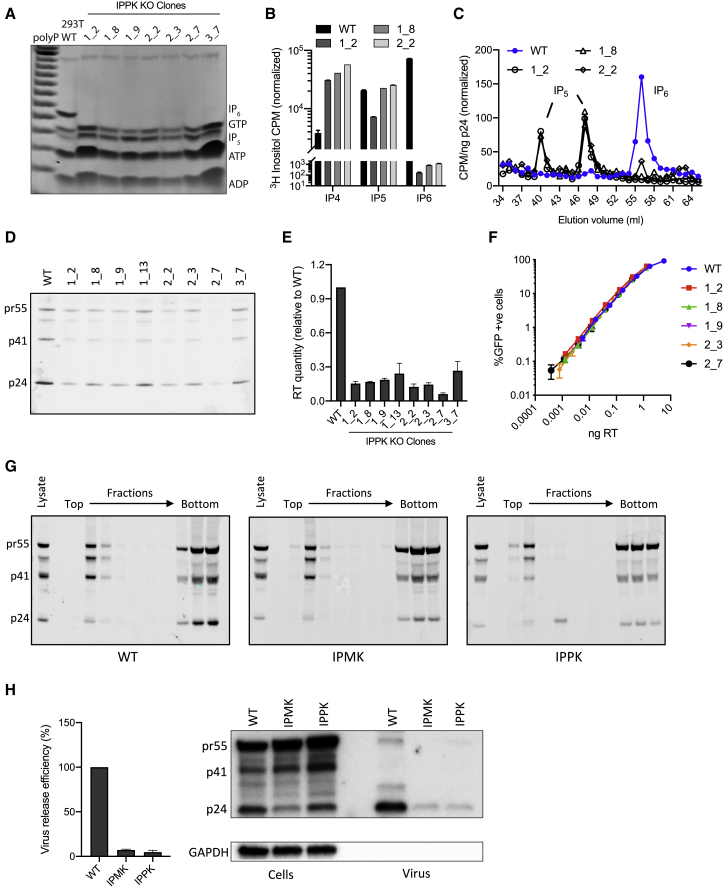
HIV Incorporates IP5 in the Absence of IP6 without Loss of Production or Infectivity(A) TiO2-PAGE and toluidine blue staining of cell extracts showing IP5 and IP6 levels in IPPK CRISPR/Cas9 knockout clones.(B) Inositol phosphate quantification in selected IPPK-KO clones using 3H-inositol labeling and inositol phosphate fractionation by SAX-HPLC.(C) Quantification of IP5 and IP6 packaging in virions produced in wild-type and IPPK-KO cells through [3H]inositol labeling, SAX-HPLC, and scintillation counting of fractions.(D) p24 western blot of pelleted virions showing p24 levels in HIV virions produced from IPPK-KO clones.(E) Measurement of virus production through quantification of RT in viral supernatants from IPMK-KO clones. Error bars depict mean ± SD of three independent experiments. Values are represented as fold WT virus, and reduction compared with WT is statistically significant (p < 0.0012 in all cases).(F) Infectivity of viruses from (E), as a function of viral dose measured by RT levels. Error bars depict mean ± SD of three replicates from one experiment representative of three independent experiments.(G) Membrane flotation analysis of cell lysates from WT, IPMK-KO, and IPPK-KO cells. Western blotting of sucrose gradient fractions for Gag show that similar levels of Gag are associated with the membrane fractions. Gag precursor Pr55Gag (pr55), p41, and mature capsid protein (p24) are indicated.(H) Virus release assays showing levels of Gag in lysates and virions after transduction of WT and KO cells with virus produced in WT cells. Graph shows relative quantification of p24 from two independent experiments and western blots. Representative data from at least two independent experiments are shown, unless otherwise indicated. CPM data are normalized to background.